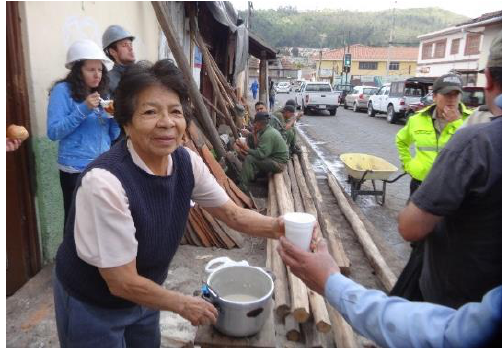
Figure 5. Neighbor, Mrs. Zoila Naula, giving refreshments to the workers. The Herrerías Maintenance Campaign.